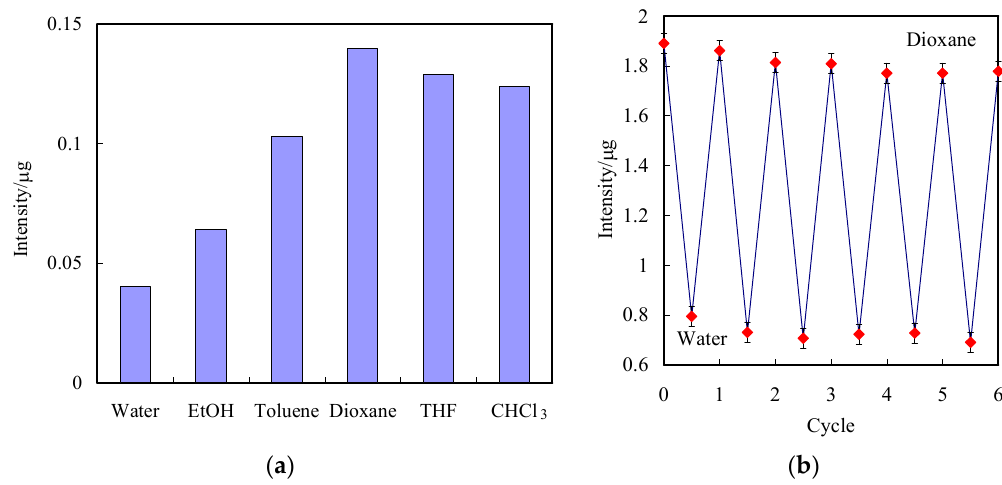
Figure 8. ( a ) Ratios of PL intensity at 395 nm of PQ1.5 after immersion in water, EtOH, toluene, dioxane, THF and CHCl 3 , respectively, to those in air. ( b ) PL intensity of PQ1.5 after six cycles of immersing in water and dioxane.